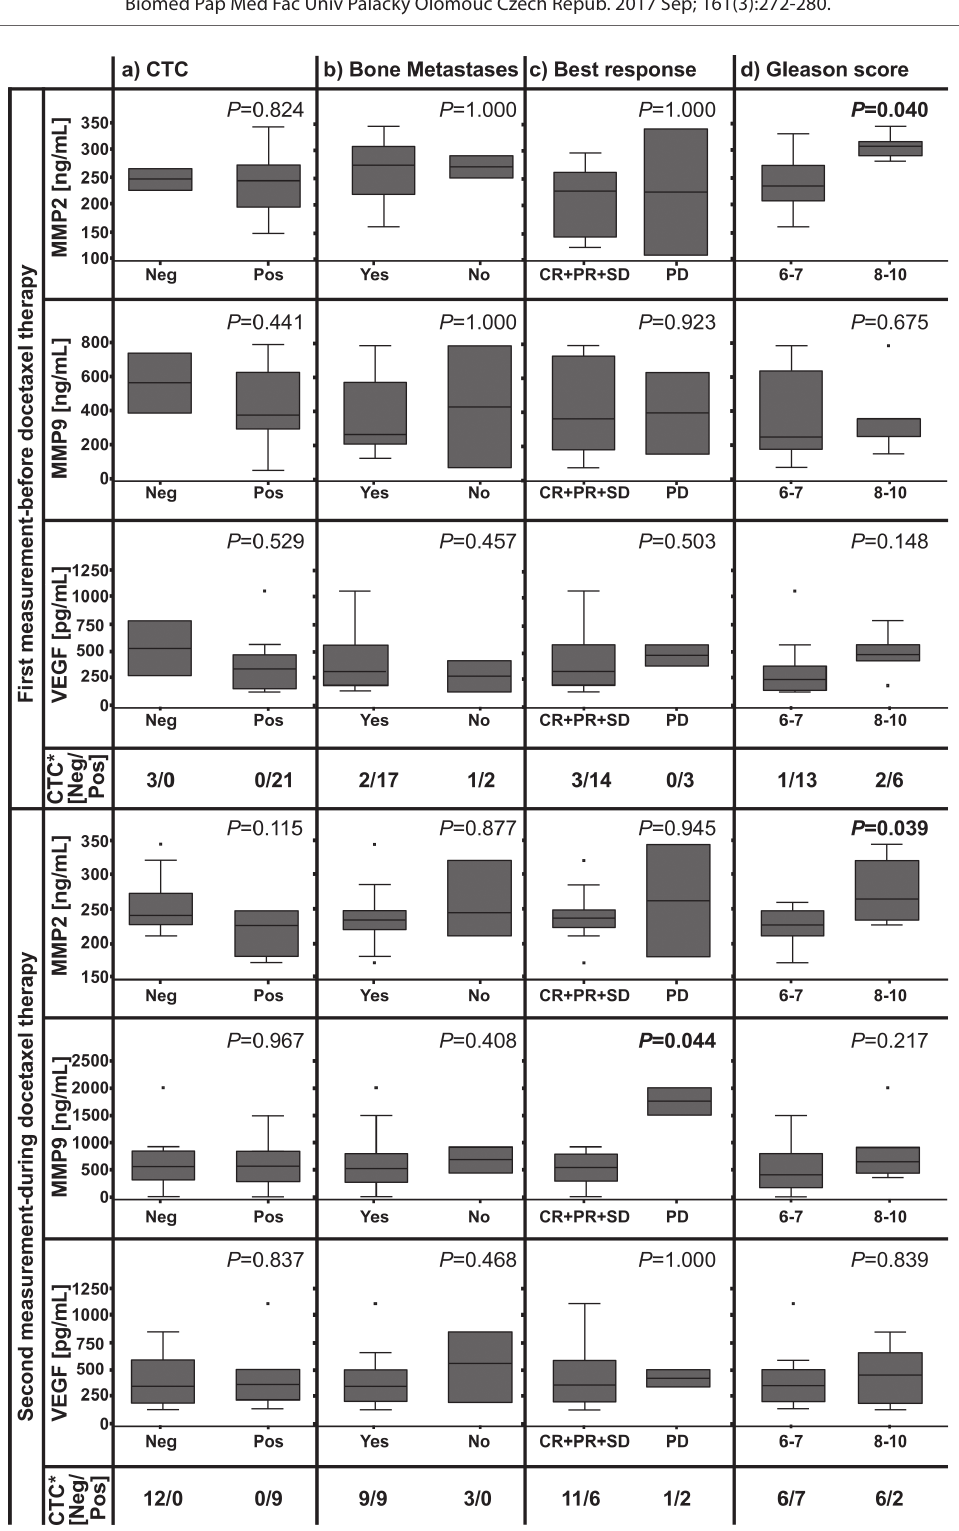
Fig. 4. The comparison of MMP-2, MMP-9 and VEGF serum levels and CTC presence in CRPC patients before and during docetaxel